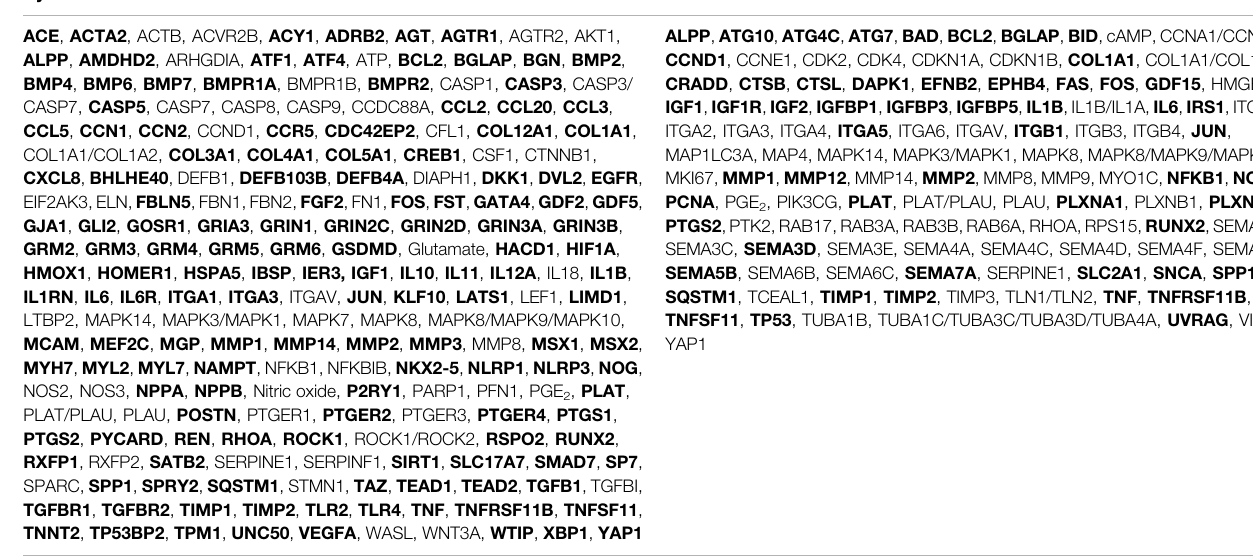
TABLE 3 | Genes, proteins and metabolites analyzed in the included studies. Differential expressed genes (DEGs) used for the subsequent gene list enrichment analysis are given in bold. Dynamic